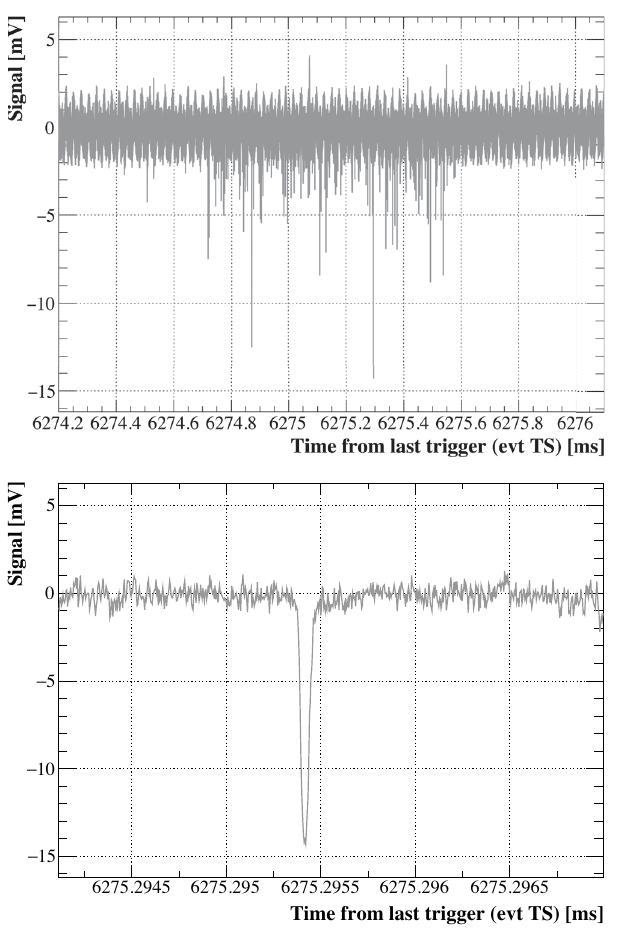
FIG. 8. Example of signals recorded in raw data during rf pulse (top) and a magnified view of one of the γ signals